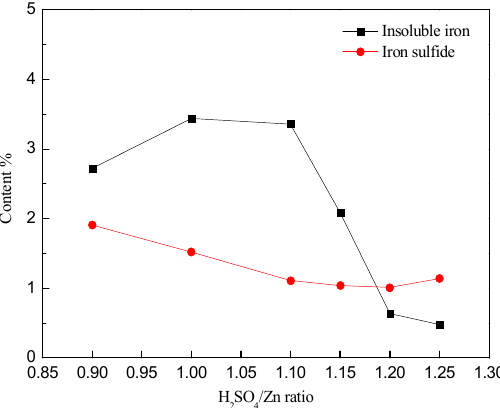
Figure 9. The content of different iron phase in the leaching residue with different H 2 SO 4 /Zn ratios.